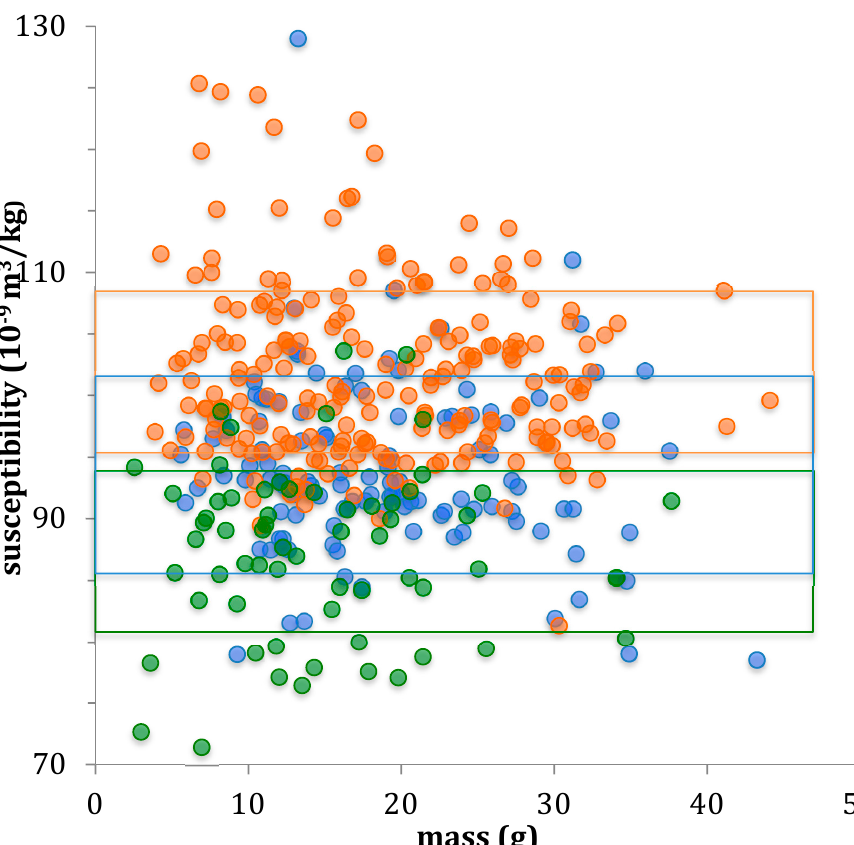
Figure 3. Magnetic susceptibility versus mass data obtained in Leyden australasite collection using SM150 instrument for three different geographic provenances: Indonesia (orange), the Philippines, and Vietnam (blue), other (rest of Indochina, Australia: green). Boxes correspond to average plus or minus one s.d, with the same color code as individual data.